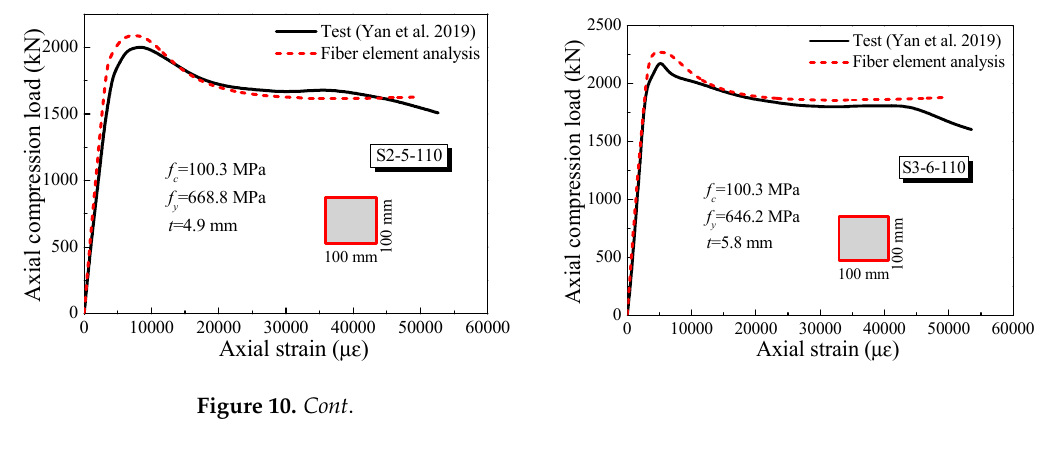
Figure 9. Calculations for the UHPCFST specimen columns SS3-2 and SS3-3 [29].